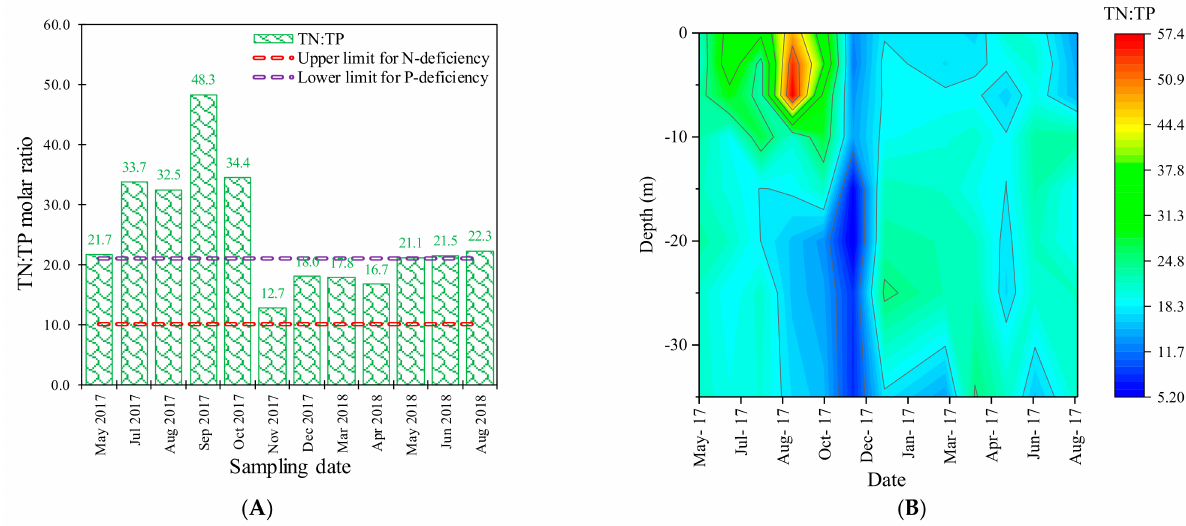
Figure 5. ( A ) Total nitrogen (TN) to total phosphorus molar ratio (TN:TP) averaged at the epilimnion (at the depths of 0.5, 3, and 6 m) in the Sabalan reservoir, and ( B ) TN:TP molar ratio through depth of the